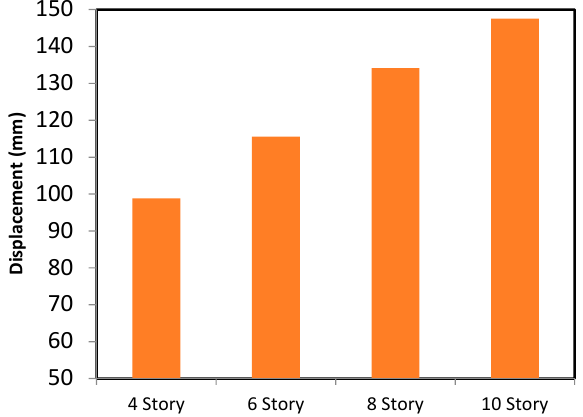
Figure 7. Comparative lateral displacement of selected buildings.